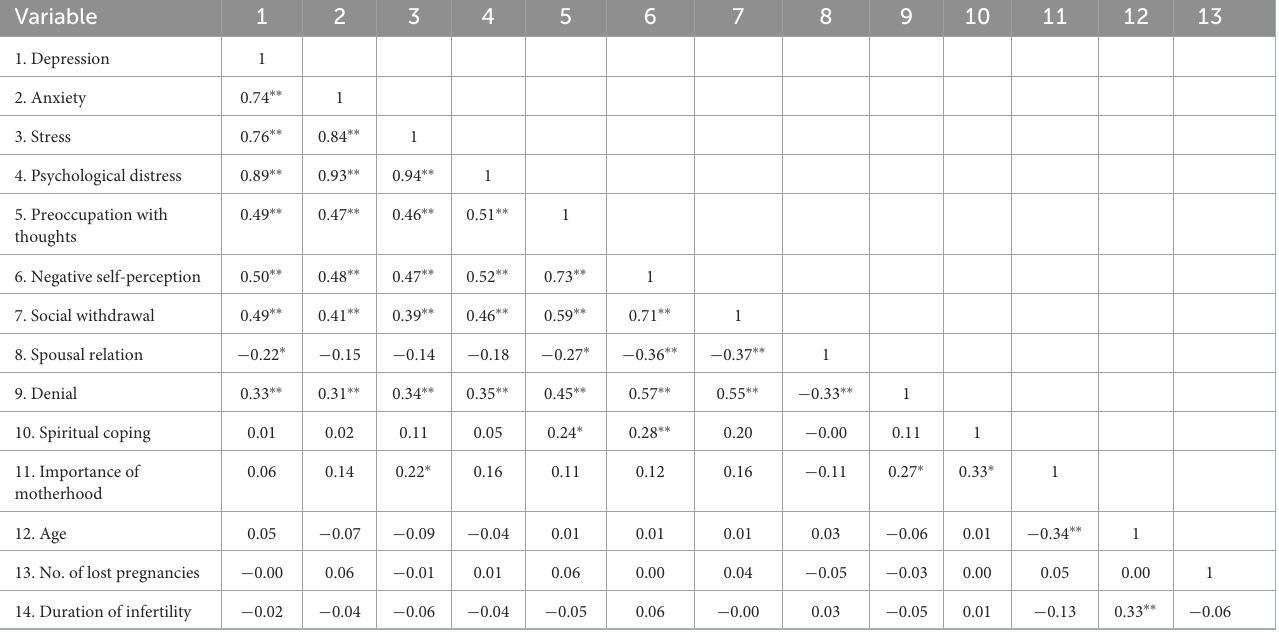
TABLE 3C Zero-order correlations among the main variables — women who are not undergoing ART ( N = 91).